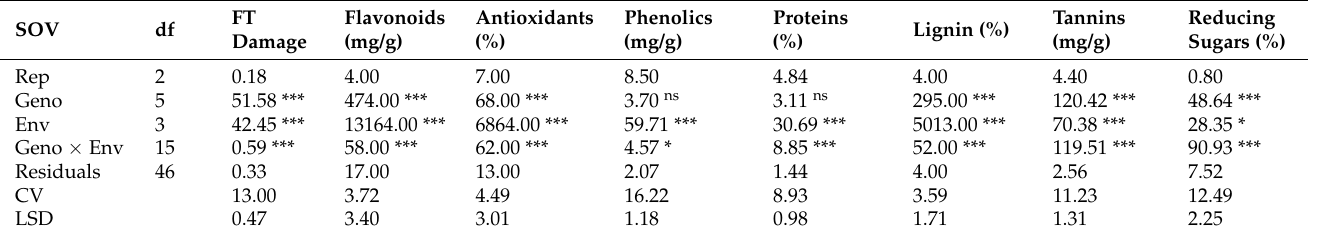
Table 3. Mean squares for secondary metabolites and flower thrips damage in cowpea genotypes across